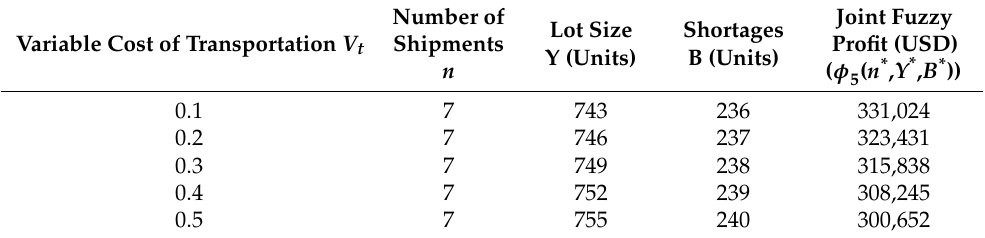
Table 13. Impact of the variable cost of transportation on the decision variables and joint fuzzy profit.